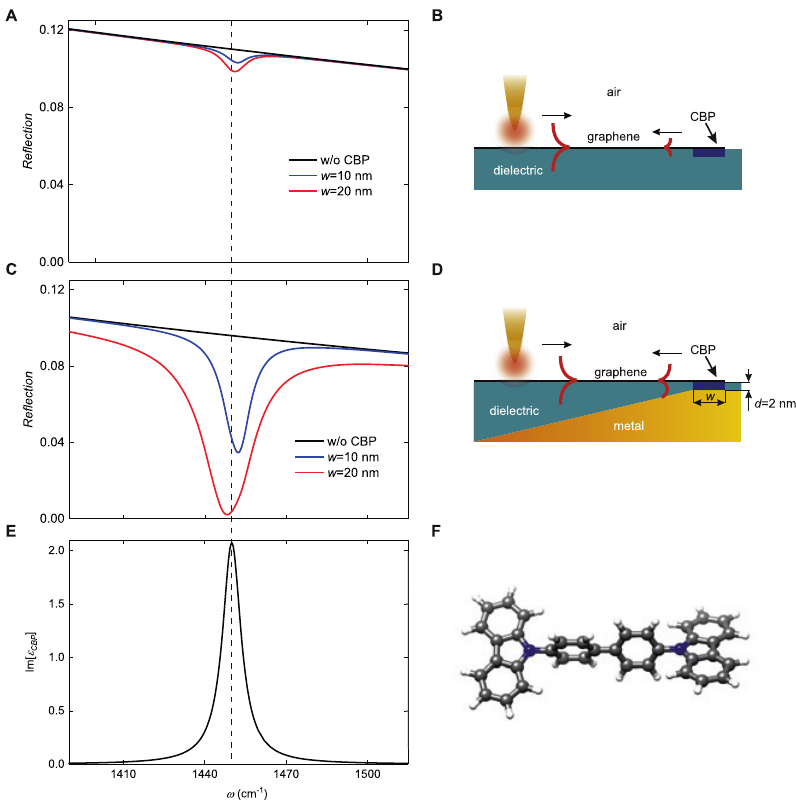
fi ngerprint provided by AGP is about one order of magni-